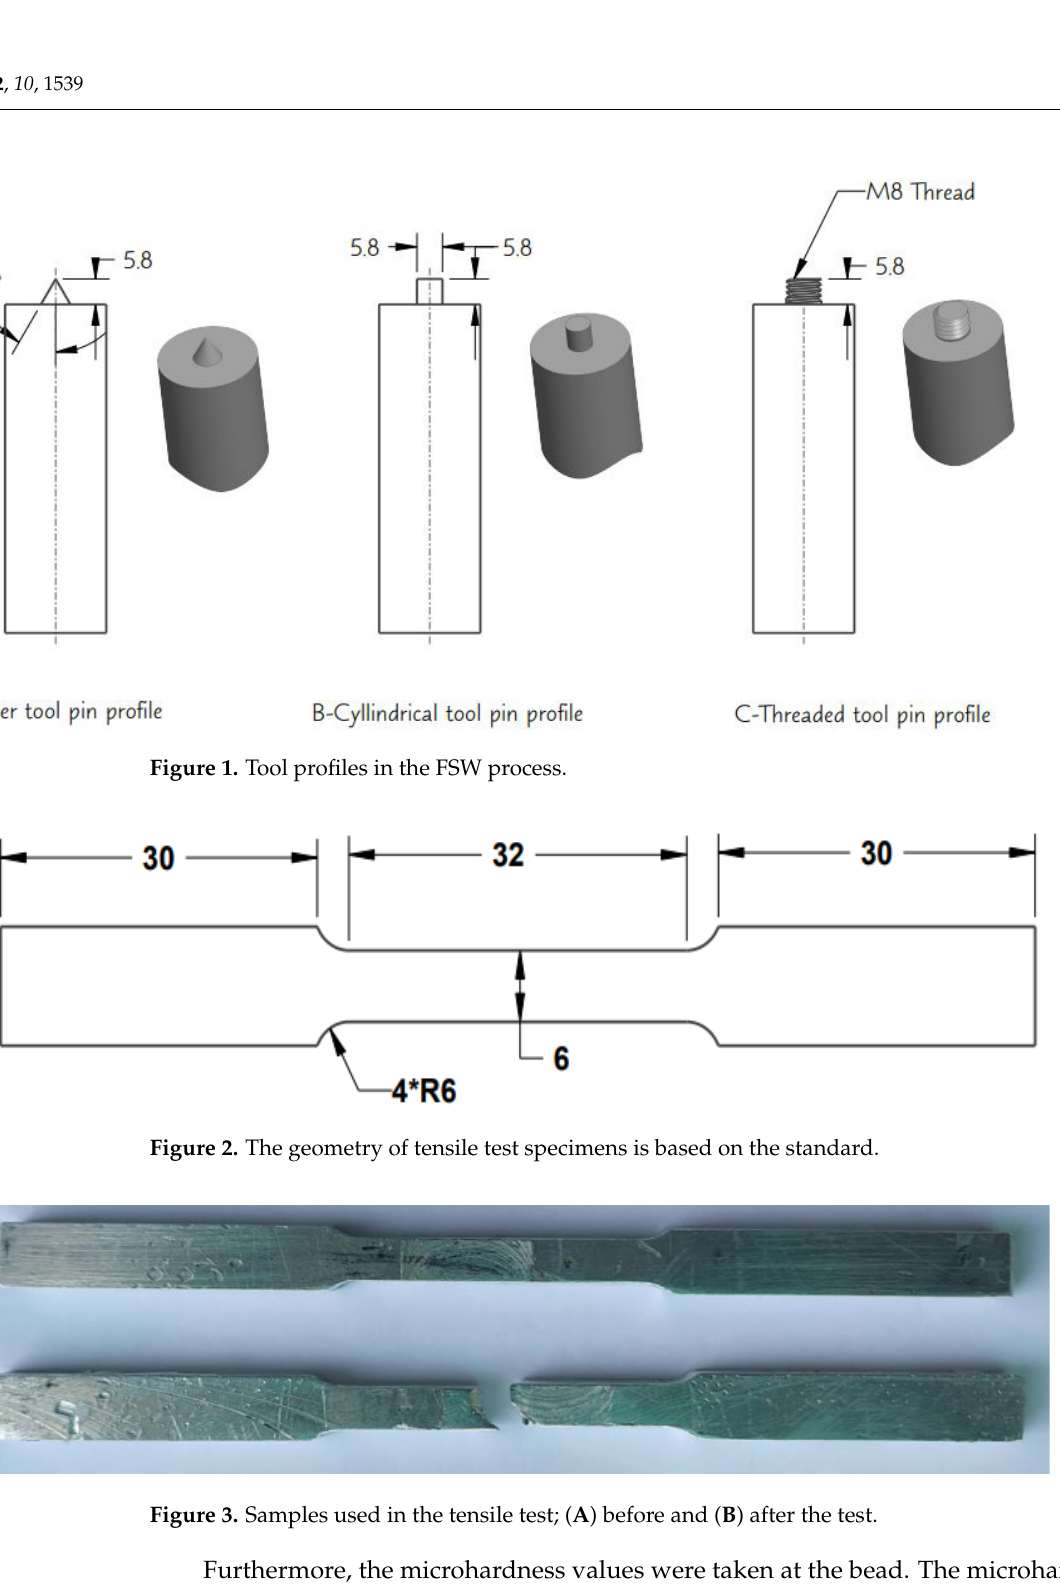
Table 3. Input variables or L 9 orthogonal array.